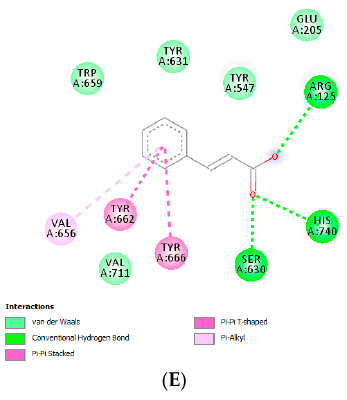
Figure 4. Ligand–Receptor Interaction: ( A ) Sitagliptin; ( B ) Brazilin; ( C ) Coumarin; ( D ) trans - cinnamaldehyde; and ( E ) trans -cinnamic acid.